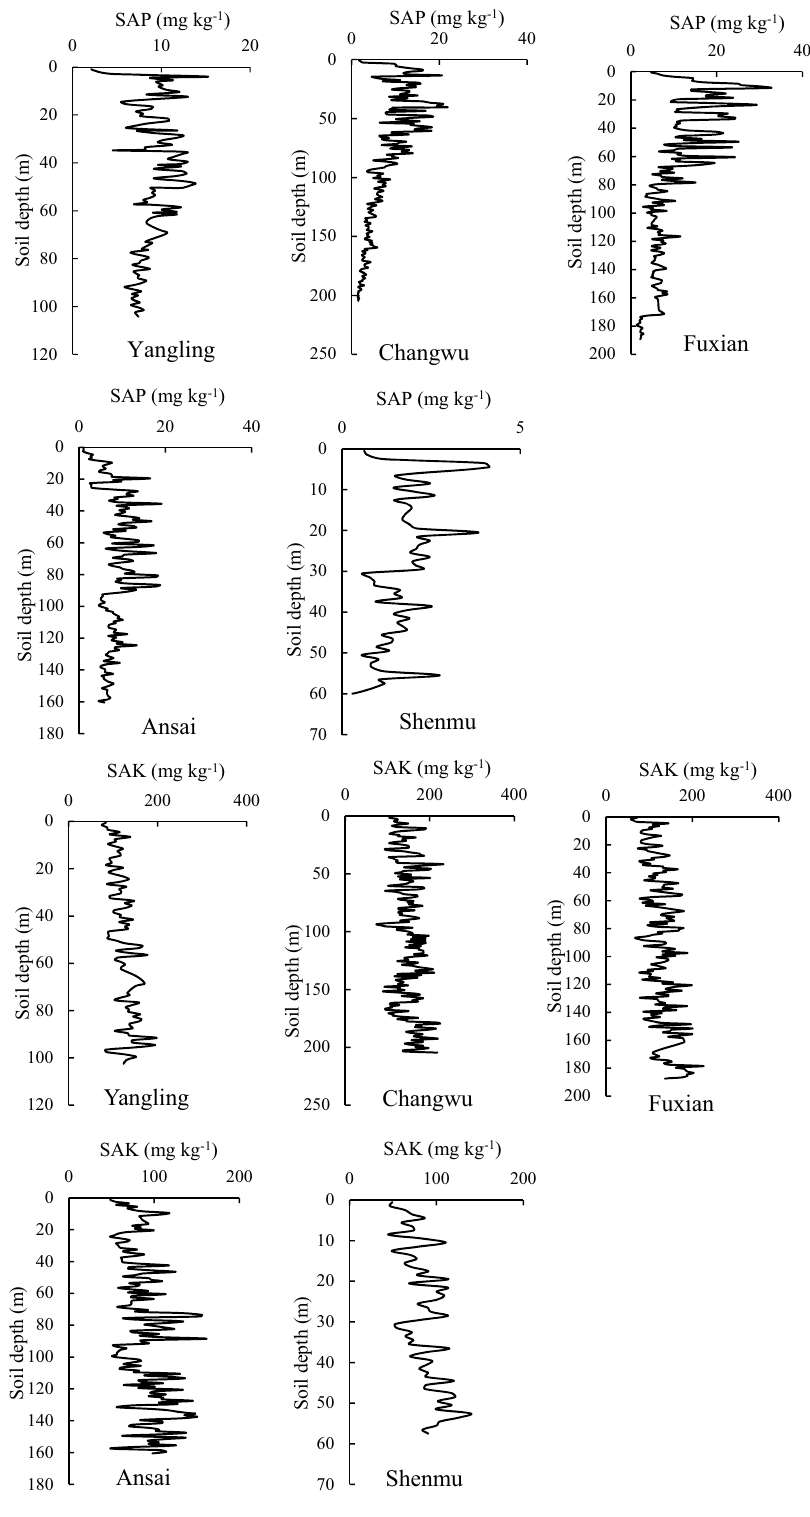
Figure 2. Vertical distributions of SAP and SAK concentrations at different sampling sites; the data extracted from GS + and mapped by Excel https ://www.micro soft.com/zh-cn/micro soft-365/excel